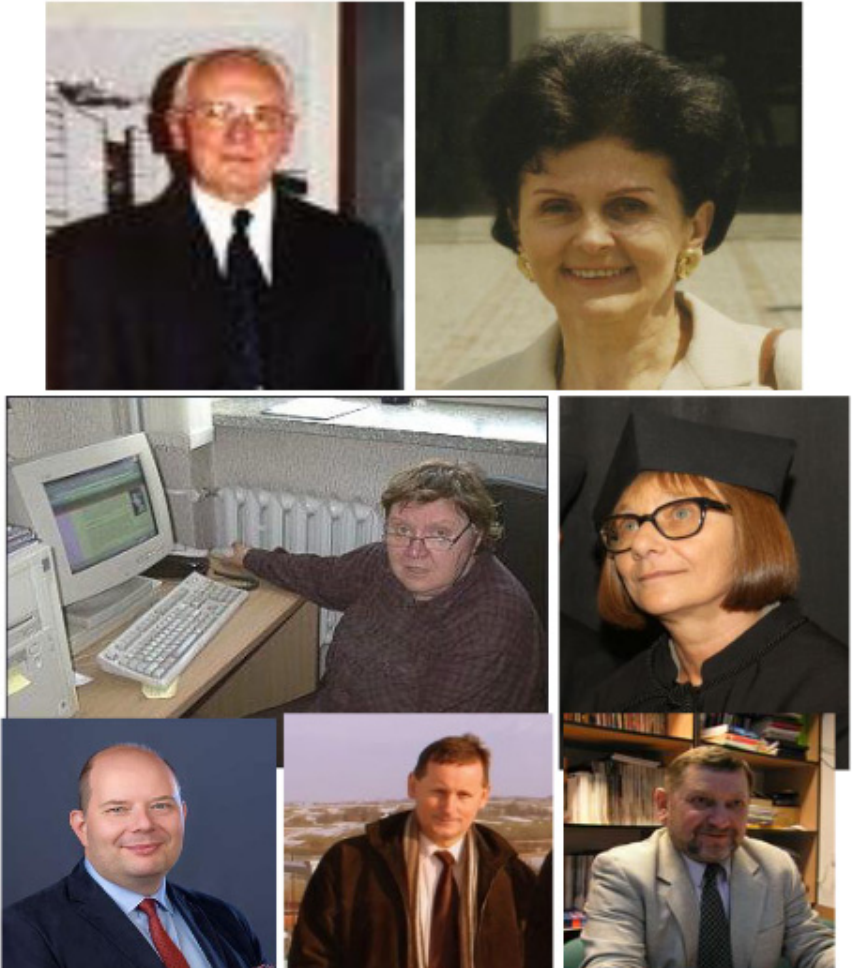
Figure 9. Silesian chromatographers from the top: J. Sliwiok, I. Staneczko-Baranowska, T. Kow-